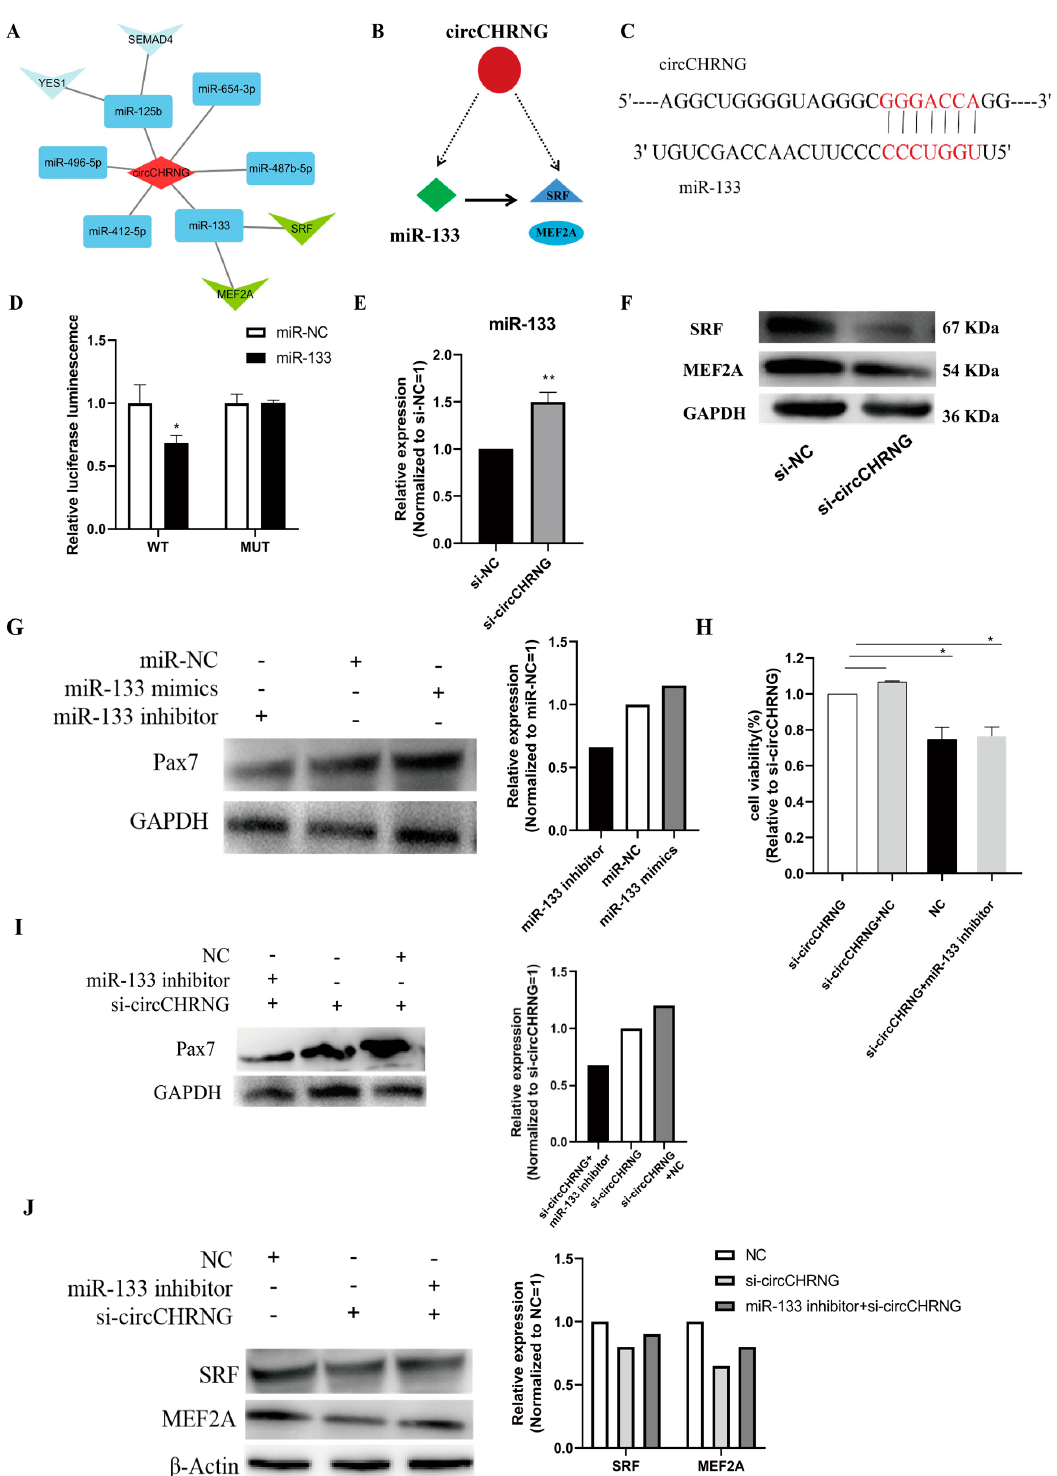
Figure 6. CircRNA–miRNA–mRNA Regulatory Circuitry. ( A ) Interaction network of circCHRNG and miRNAs. ( B ) Illustration of predicted circuitry including miR-133, circCHRNG, and SRF. The red node represents circRNAs; green node represents miRNA; blue node represents key genes related to myogenesis; the solid line represents the real regulatory effect; the dashed line represents the predicted regulatory effect. ( C ) The potential binding sites of miR-133 in circCHRNG. ( D ) circCHRNG wild-type (WT) or mutant (MUT) luciferase reporters and miR-133 mimics, or mimic negative control (NC), were co-transfected in 293T cells. ( E ) Expression of miR-133 in ovine SMSCs transfected